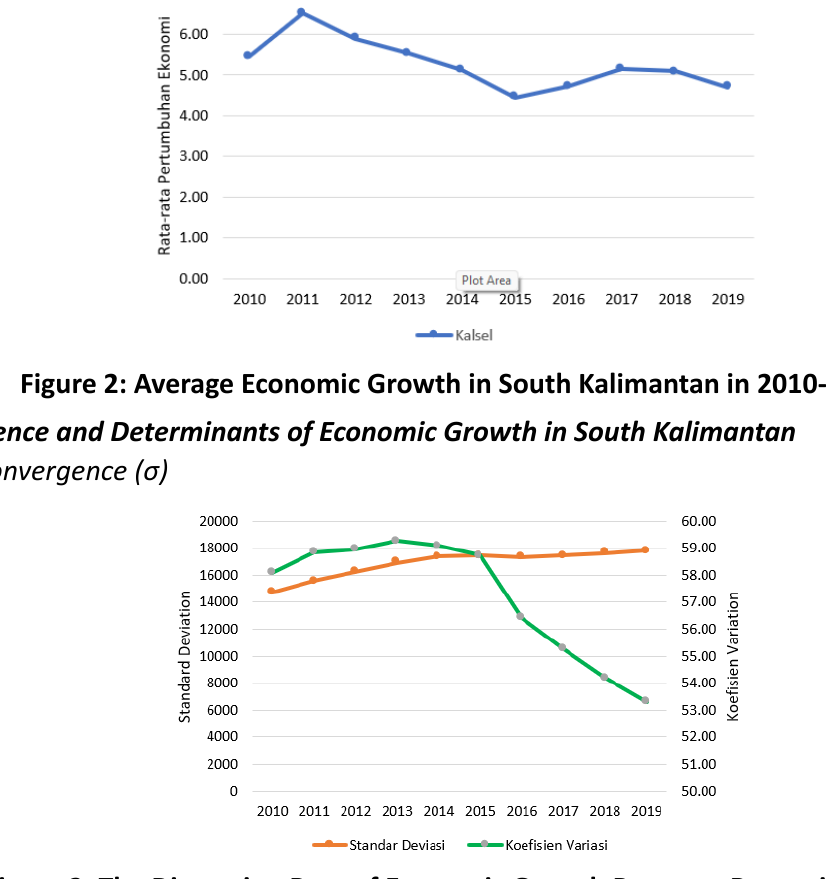
Figure 3: The Dispersion Rate of Economic Growth Between Regencies and Cities in South Kalimantan in